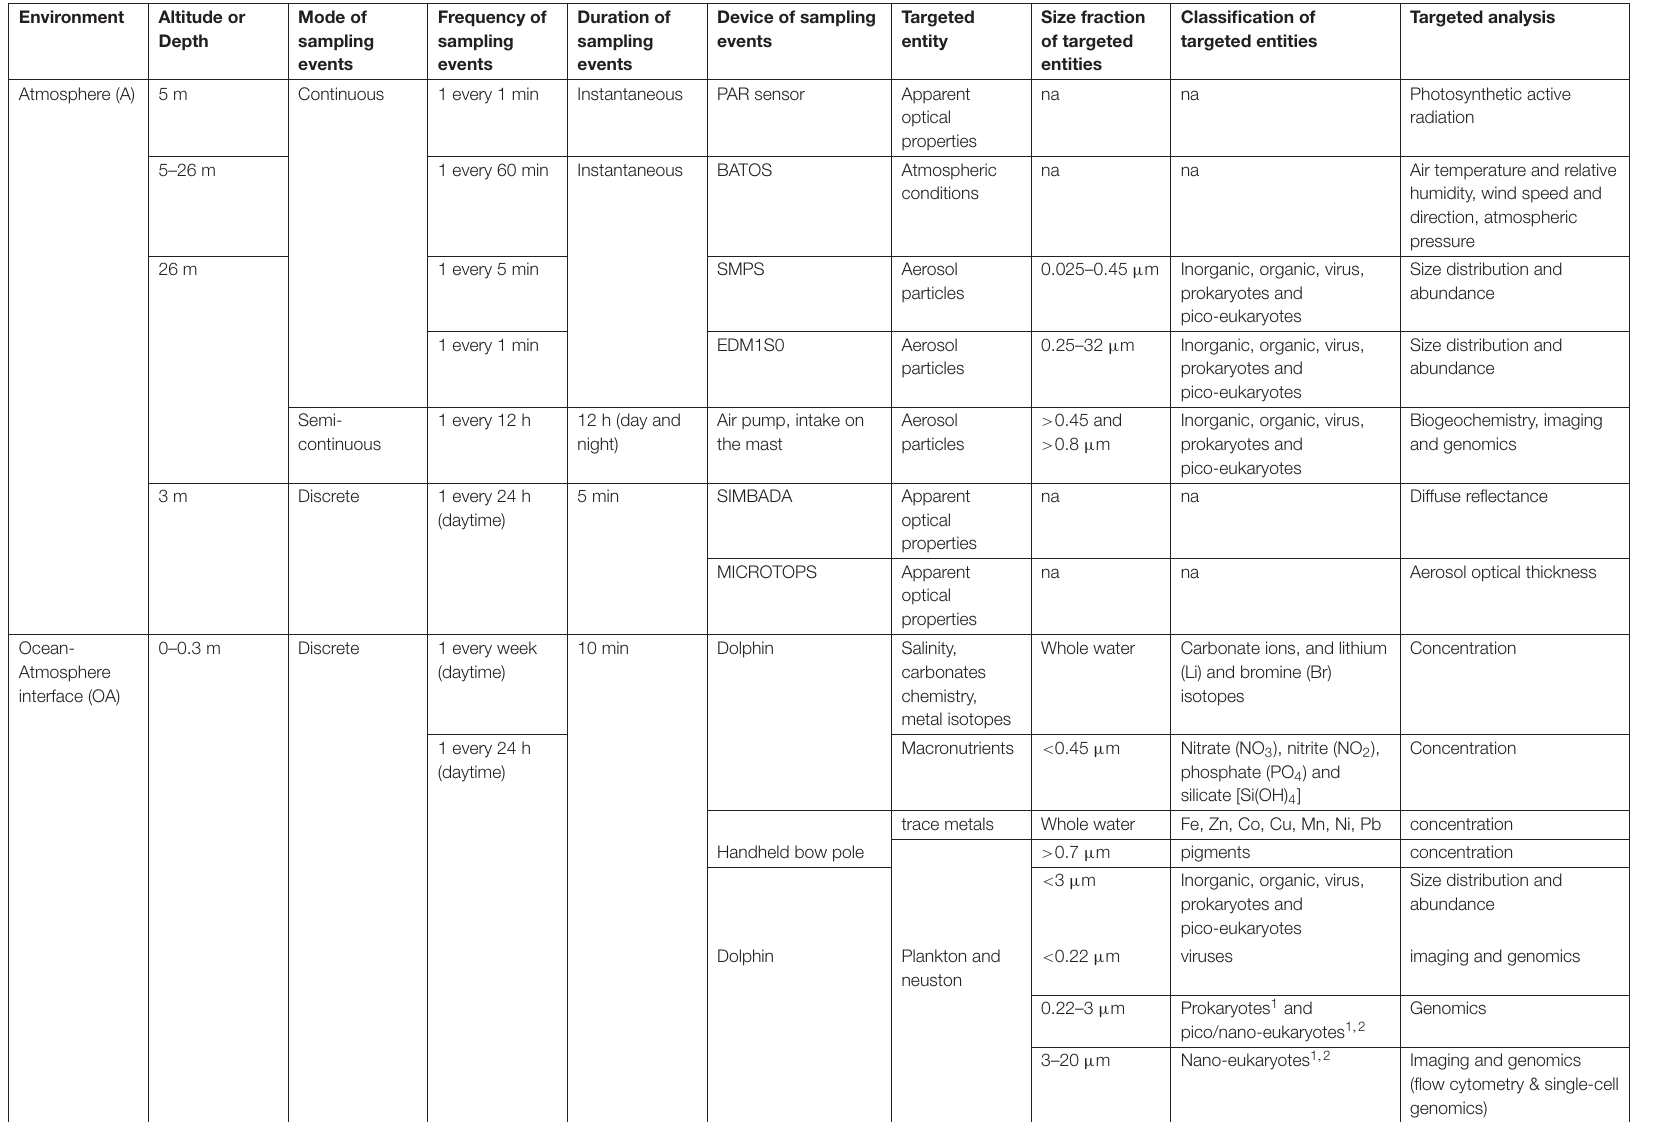
TABLE 1 | Summary of the Tara Pacific “ecosystemic sampling of the ocean-atmosphere interface” protocols, targeted entities and analyses of samples from above, below and the sea-surface.